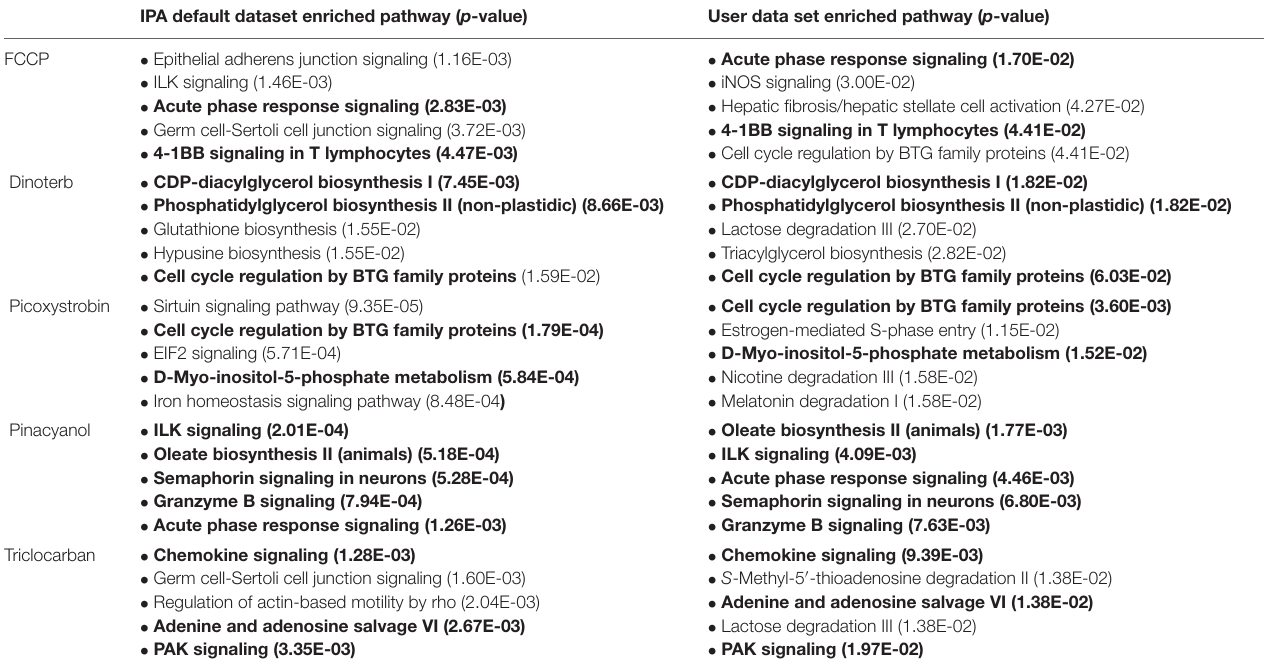
TABLE 1 | Pathway enrichment analysis by Ingenuity Pathway